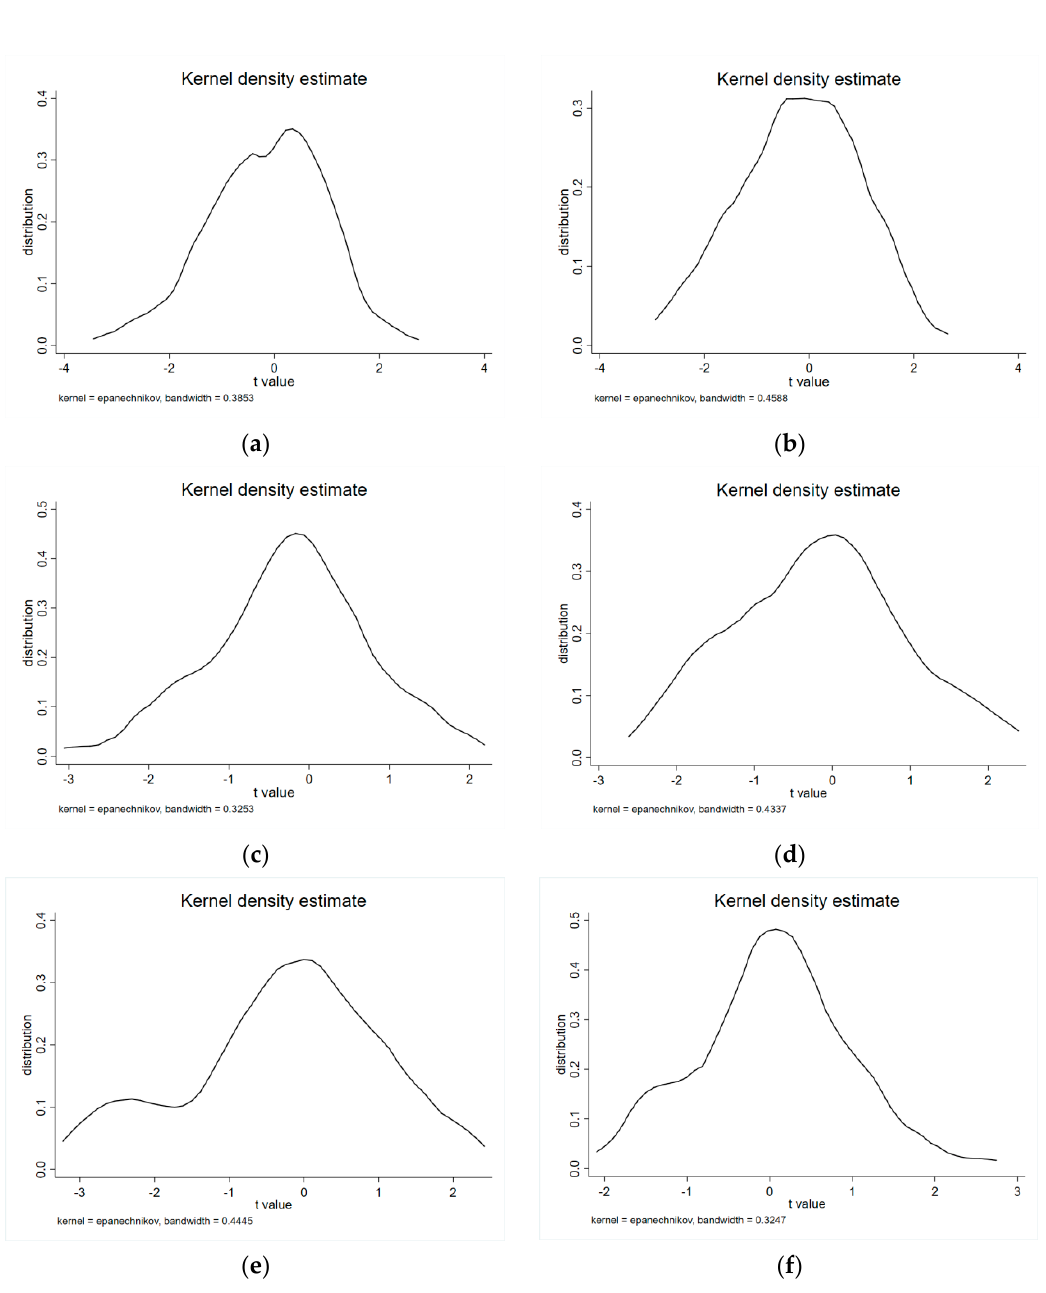
Figure 3. Distribution of estimated coefficients (( a ) PM 2.5 , ( b ) PM 10 , ( c ) SO 2 , ( d ) NO 2 , ( e ) CO, ( f ) O 3 ).